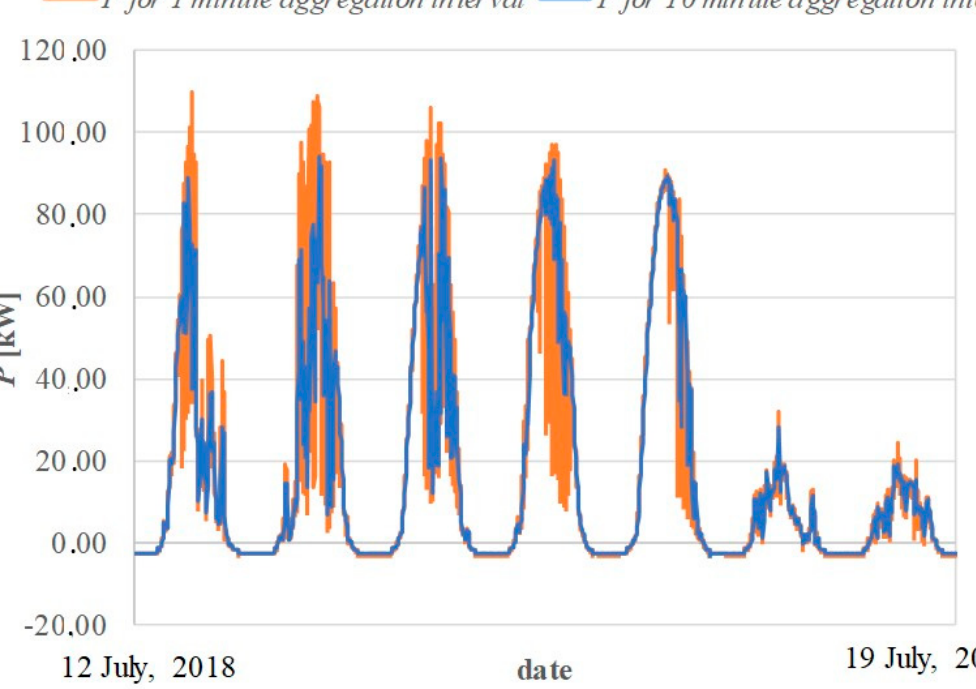
Figure 2. Active power generation of observed PV power plant during selected week using 1 min and 10 min aggregation intervals.